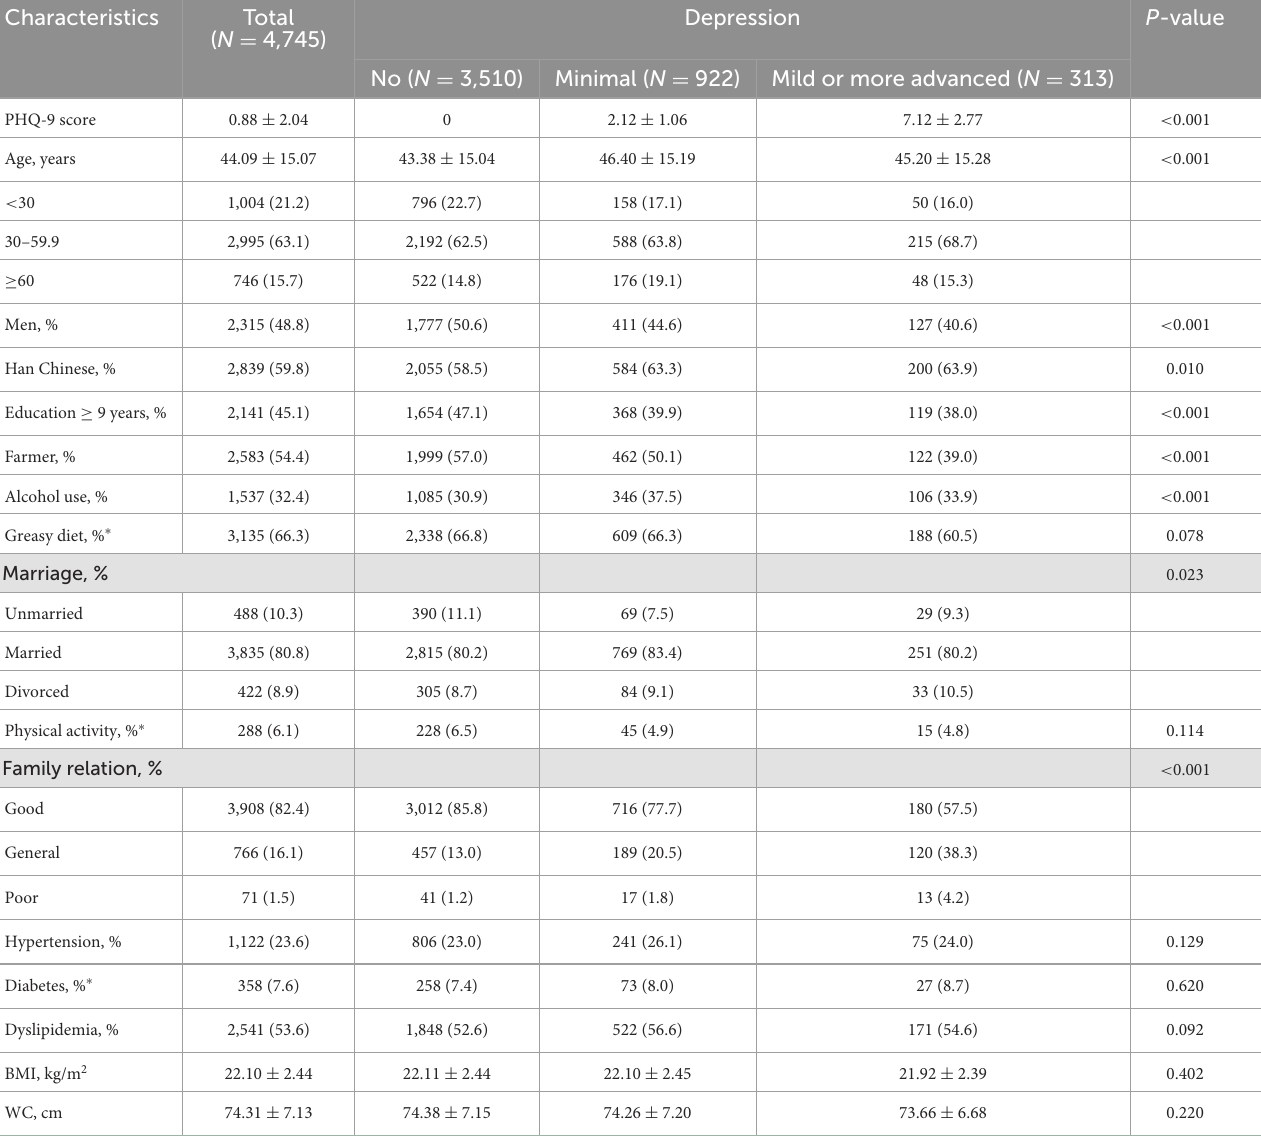
TABLE 1 General characteristics of Chinese adults without obesity at baseline over depression groups.